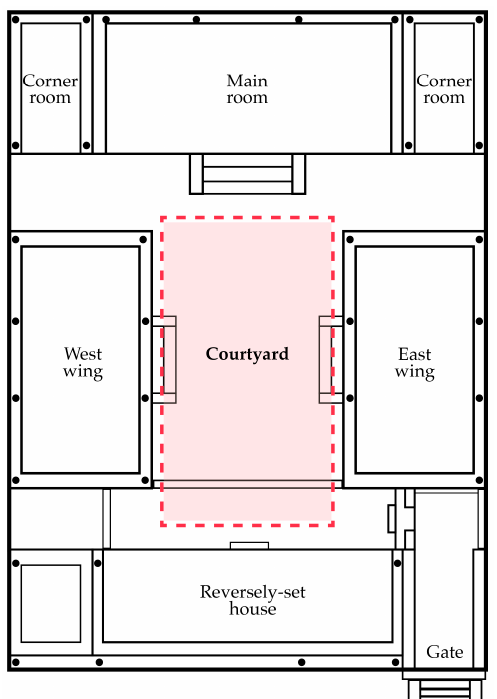
Figure 1. Layout of traditional courtyard houses in northern China (Drawn by authors).